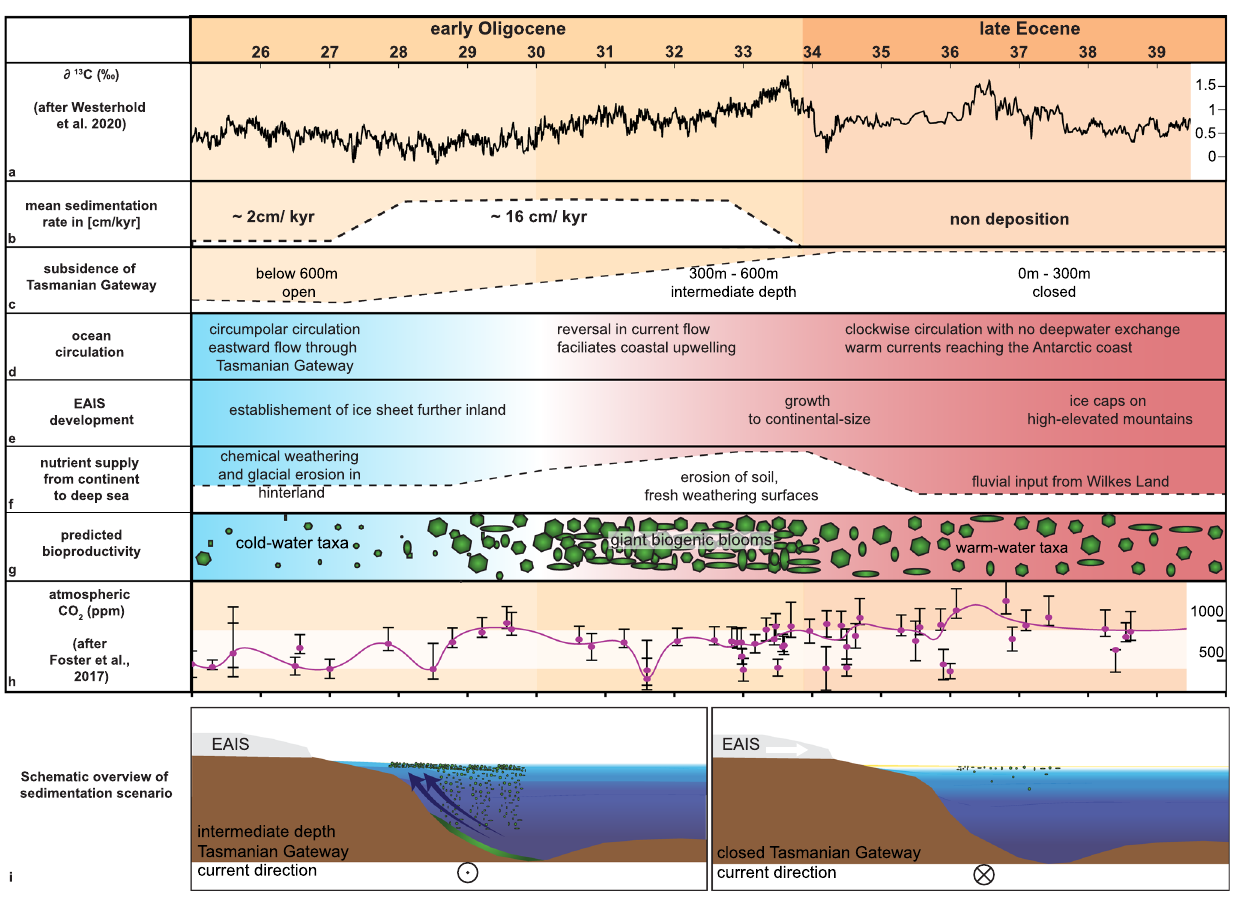
Fig. 4 | Overview of the development of the Australian – Antarctic Basin betweenthelateEoceneandearlyOligocene.a ∂ 13 C 12 , b sedimentationrates(this study), c subsidence of the Tasmanian Gateway (Sauermilch et al. 44 ), d ocean cir- culation(thisstudyandVillaetal. 51 ), e EastAntarcticIceSheet(EAIS)development, f nutrient supply from continent (Passchier et al. 32 ), g predicted bioproductivity